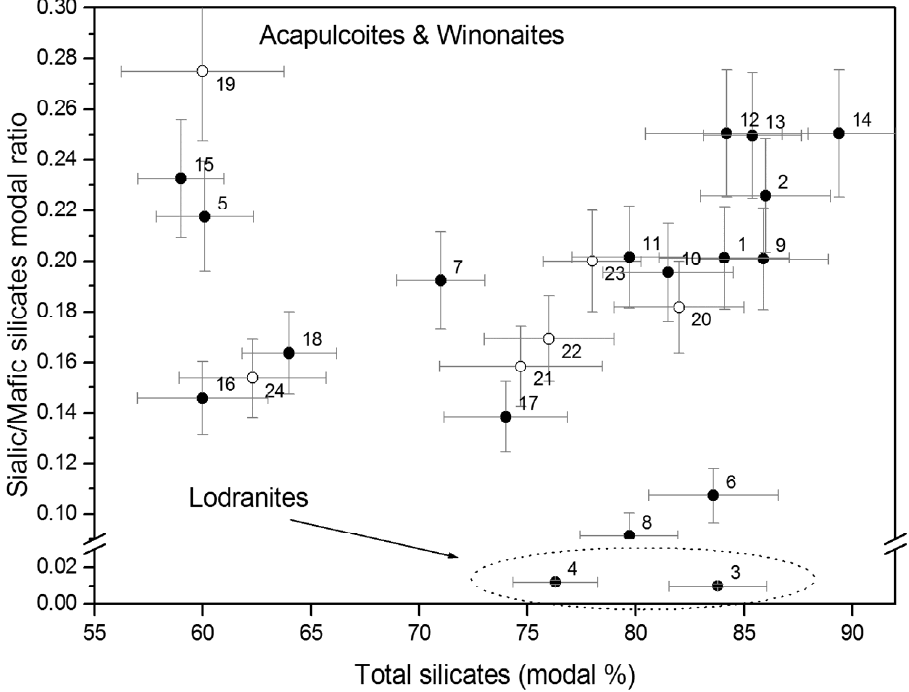
Figure 4. Plagioclase/mafic silicate ratio as a function of the total amount of silicates; full circles are data of this study, empty circles literature data (samples from 19 to 24). Numbers refer to samples as indicated: 1 = Y-74063; 2 = Y-74025; 3 = Y-74357; 4 = Y-791491; 5 = Y-8005; 6 = QUE 94535; 7 = GRA 98028; 8 = ALH 81187; 9 = ALH 81261; 10 = ALHA77081; 11 = A-881902; 12 = NWA 1052; 13 = NWA 1054; 14 = NWA 3008; 15 = NWA 1058; 16 = NWA 1463; 17 = DHO 290; 18 = Pontlyfni; 19 = NWA 725; 20 = TIL 99002; 21 = Monument Draw; 22 = Mt. Morris; 23 = Y-75300; 24 = Y-75305. See Table 2 for sample